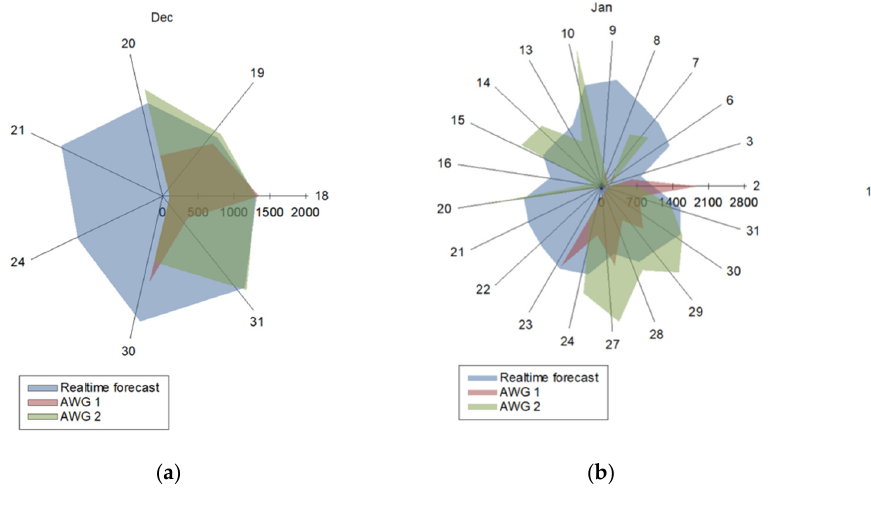
Figure 6. Comparison between apparent and real water yield under pristine conditions during the months of ( a ), December 2019; ( b ) January 2020; and ( c ) February